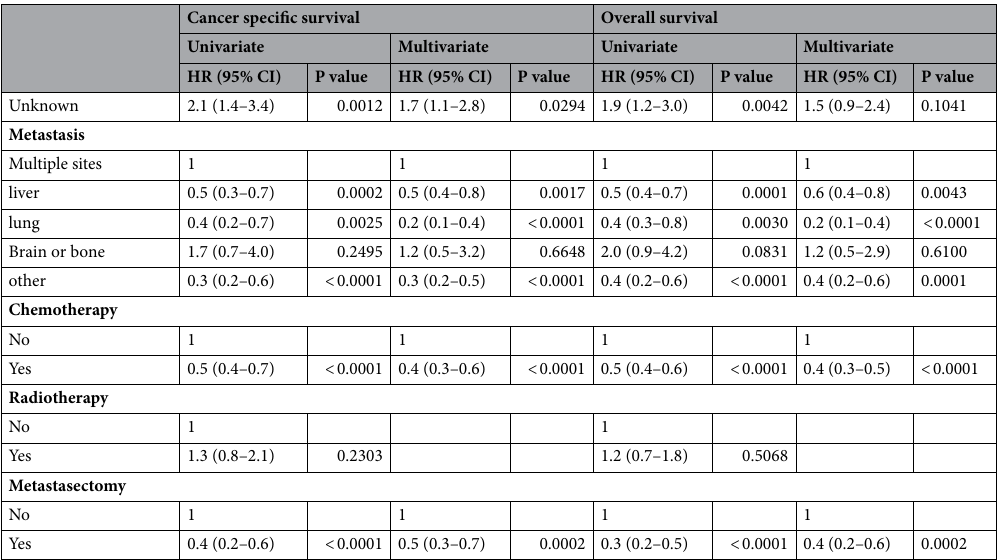
Table 3. Prognostic factors for cancer specific survival and overall survival for patients with stage T1 colorectal cancer. HR hazard ratio, CI confidence interval; *Single includes divorces/separated/widowed/